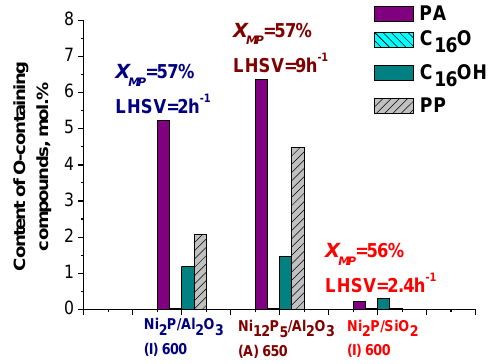
Figure 14. Composition of oxygen-containing compounds depending on the catalyst: NiP_I/Al 2 O 3 (600), NiP_A/Al 2 O 3 (650) and NiP_I/SiO 2 (600) catalysts at T = 290 °C, P H2 = 3.0 MPa, H 2 /feed = 600 Nm 3 /m 3 and methyl palmitate LHSV was adjusted to obtain nearly the same methyl palmitate conversion (2.4–12 h –1 ). Notation: PA–palmitic acid, C 16 O–hexadecanal, C 16 OH–hexadecanol, PP–palmityl palmitate.